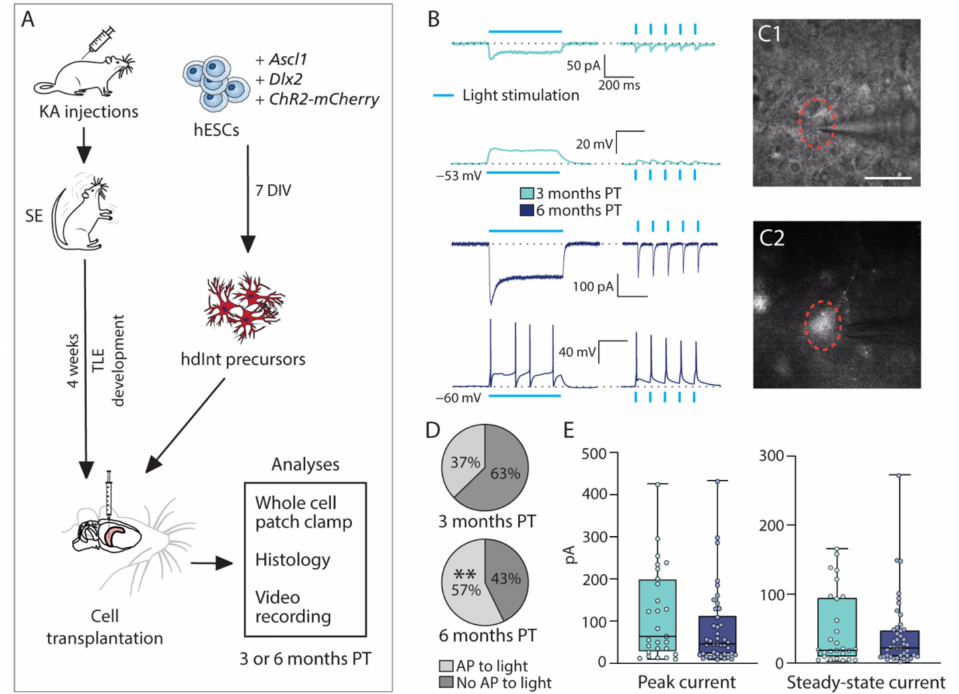
Figure 1. Experimental timeline and optogenetic properties of grafted hdInts. ( A ) Schematic represen- tation of the timeline of the study. ( B ) Voltage- and current-clamp traces from ChR2-expressing